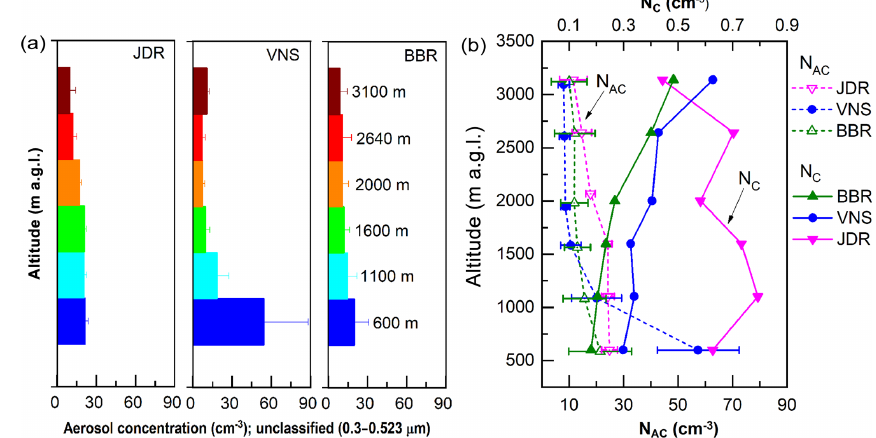
Figure 4. Vertical profiles of aerosol number concentrations in the (a) unclassified size range of APS (between 0.3 and 0.523µm); (b) accu- mulation ( N AC < 1µm) and coarse ( N C > 1µm) mode size range.